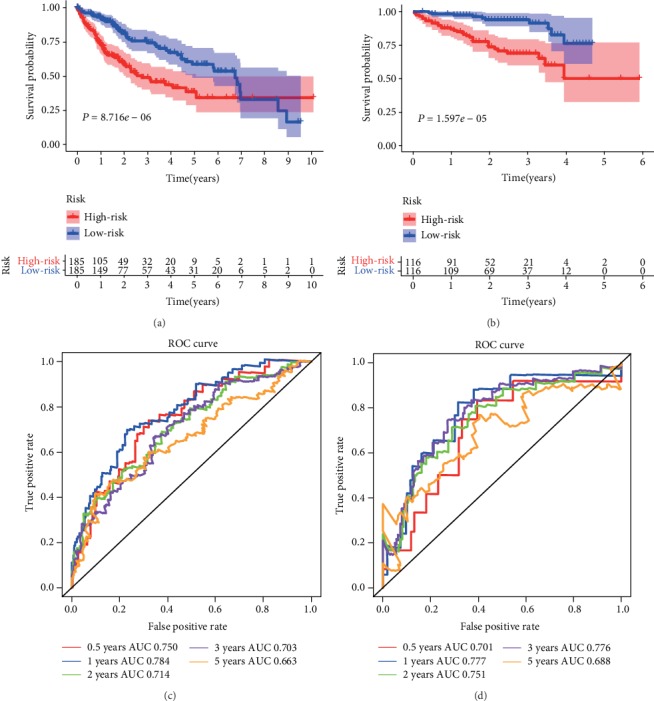
Survival analysis of the three-gene signature in training and validation datasets. Survival possibility was estimated using the Kaplan-Meier method for HCC patients assigned to high-and low-risk groups by the risk score in the TCGA (a) and ICGC (b) datasets. Patients with a higher risk score had a poorer prognosis in the training and validation datasets. The ROC curve was used to verify the predictive efficiency of the risk score in the TCGA (c) and ICGC (d) datasets.